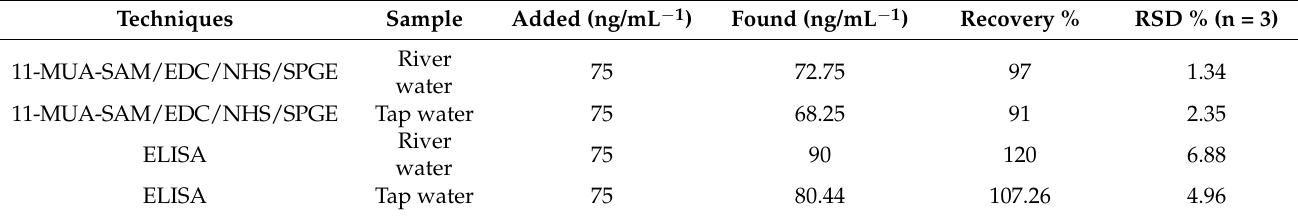
Table 6. MUA-SAM/EDC/NHS/SPGE and ELISA (immunoassay) for the determination of Aroclor 1254 in tap and river water.